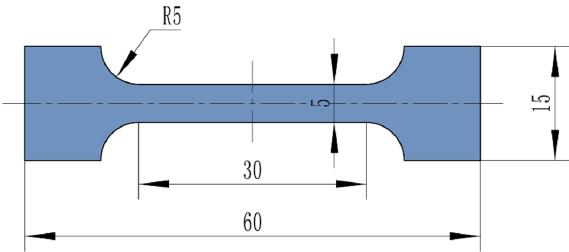
Figure 1. The dimensions of the tensile specimen